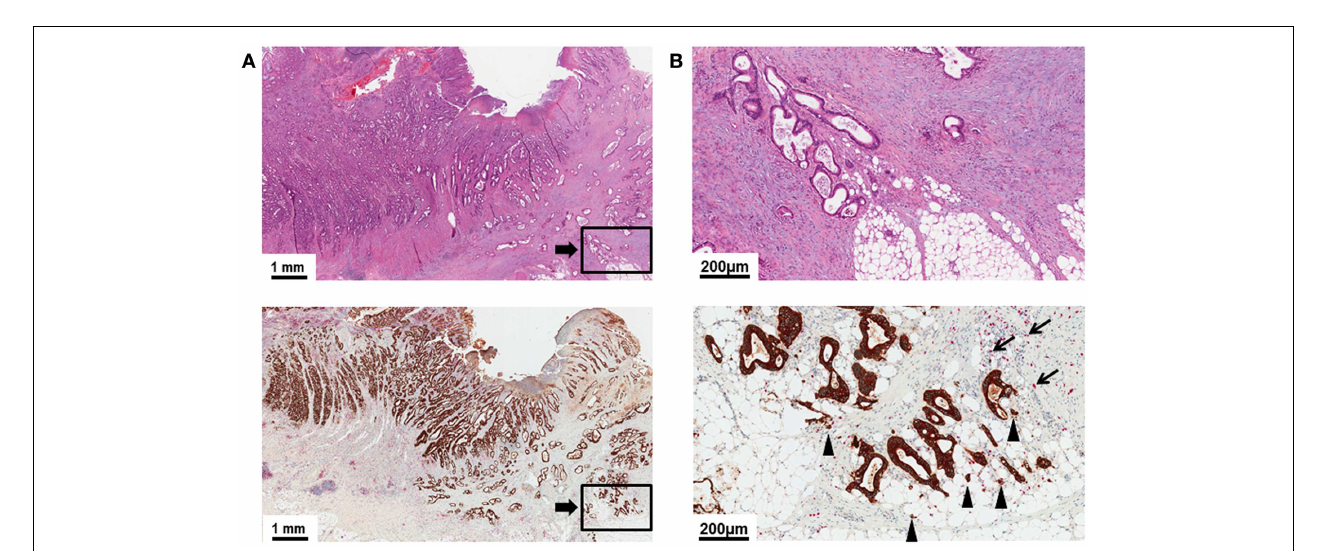
(B) High power detail (20 × ) of (A) . Note the diffuse dissection of irregularly shaped tumor glands through the mesenteric adipose tissue. CD8 + lymphocytes at the tumor invasive front are infrequent (arrows).Tumor buds invading the stroma ahead of the invasive front can be identified as a superimposed feature (arrow